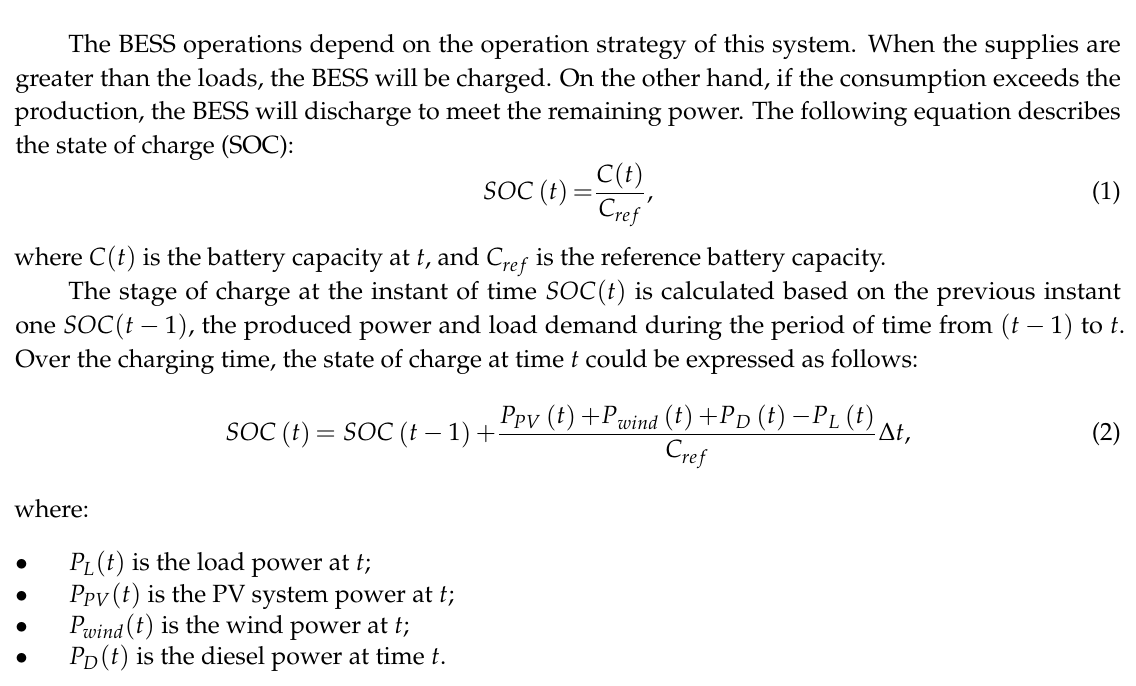
Figure 1. The configuration of the hybrid